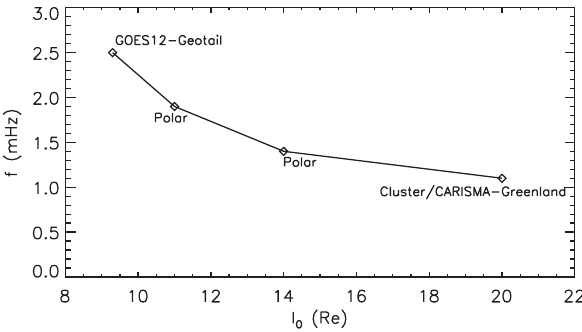
Fig. 16. The frequency ( f ) versus l shell relationship based on the